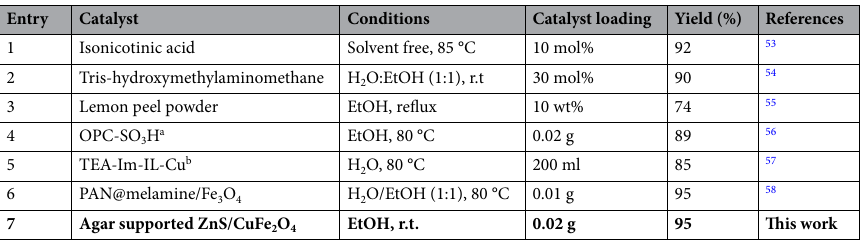
Table 3. Comparison of the catalytic performance of the the agar supported ZnS/CuFe 2 O 4 catalyst with some other reported catalysts for the synthesis of dihydropyrano[2,3-c]pyrazole (product 5b ). a Carbon powder derived from waste orange peel-SO 3 H. b Triethanolamine–imidazole–ionic liquid–Cu. Significant values are in